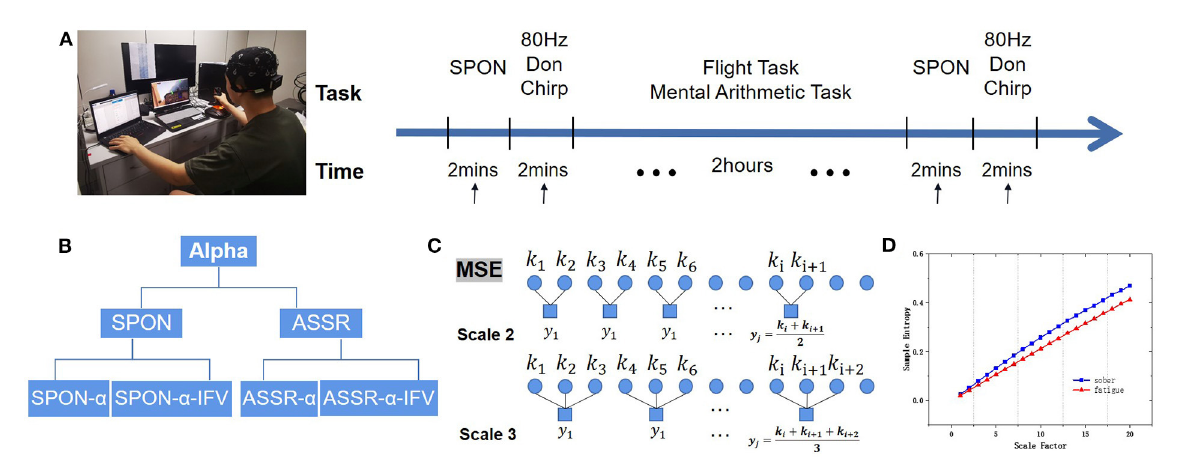
FIGURE1 Experimental protocol. (A) Experimental flow diagram of EEG acquisition of spontaneous EEG (SPON) and auditory steady-state response (ASSR) in Sober and MF states. (B) Alpha rhythm extraction from SPON and ASSR with and without instantaneous frequency variation method (IFV), producing preprocessed four types of time series, SPON- α , SPON- α -IFV, ASSR- α , and ASSR- α -IFV, before they were analyzed by multiscale entropy methods (MSE) to compare Sober and MF states. (C) Schematic diagram of the coarse graining process, taking scale 2 and scale 3 as examples. (D) An example of MSE